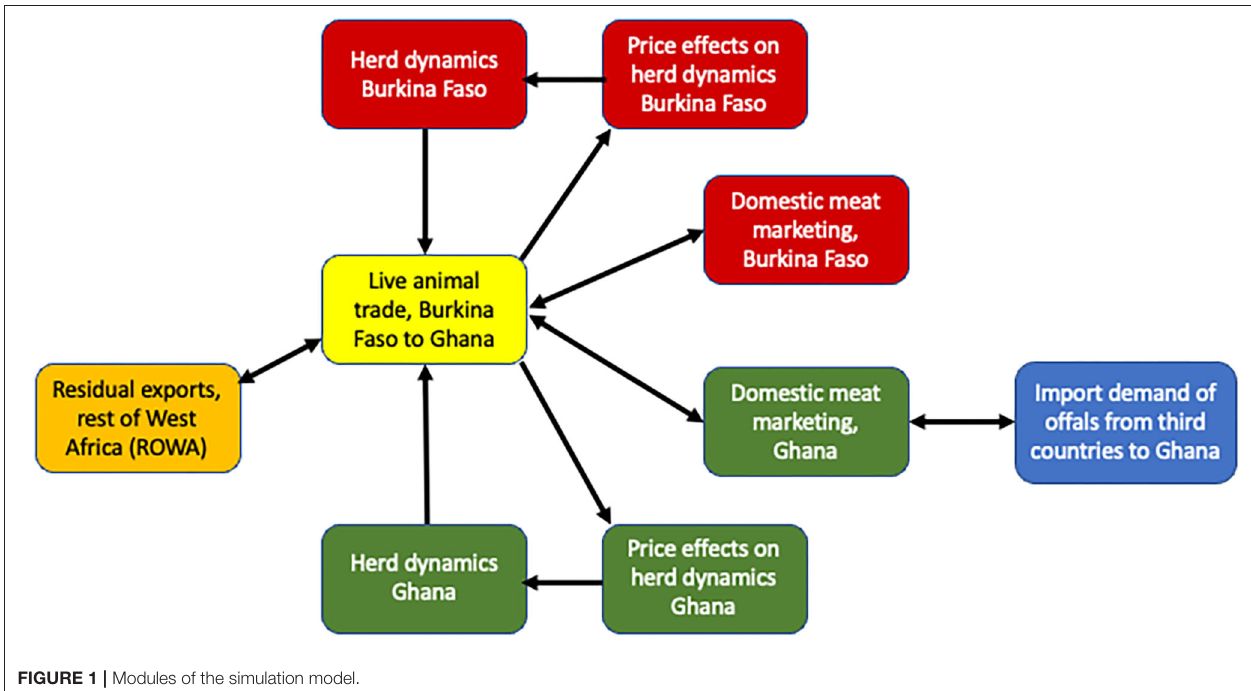
FIGURE 1 | Modules of the simulation model.